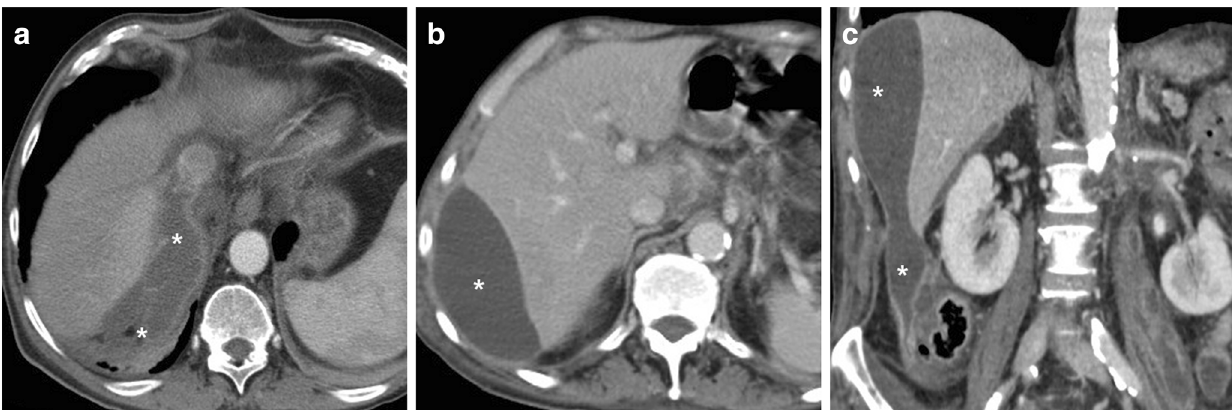
Fig. 12 The most common appearance of post- cholecystectomy bleeding. a , b Forty-eight hours after open cho- lecystectomy converted from lap- aroscopic cholecystectomy, CT showed perihepatic blood (*) isoattenuating with the liver on precontrast scans ( a ), oozing ex- ternally from drainage ( thick arrows ), without appreciable contrast extravasation on both ar- terial ( b ) and venous (not shown) enhanced phases. Reintervention was required to achieve haemostasis at the gallbladder fossa and omentum. c , d On the 3rd postoperative day after lapa- roscopic cholecystectomy, precontrast ( c ) and contrast- enhanced ( d ) CT images showed hyperattenuating fresh blood (*) extending from the surgical bed below the right liver lobe, in the right parietocolic and peritoneal cul-de-sac. The patient was treat- ed by positioning of percutaneous drainage